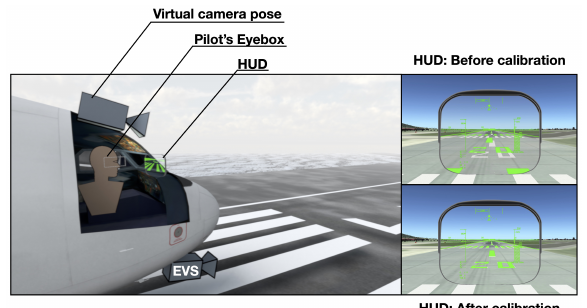
Figure 1. Configuration of pilot’s eyebox, virtual camera, enhanced vision camera (EVS) and head-up